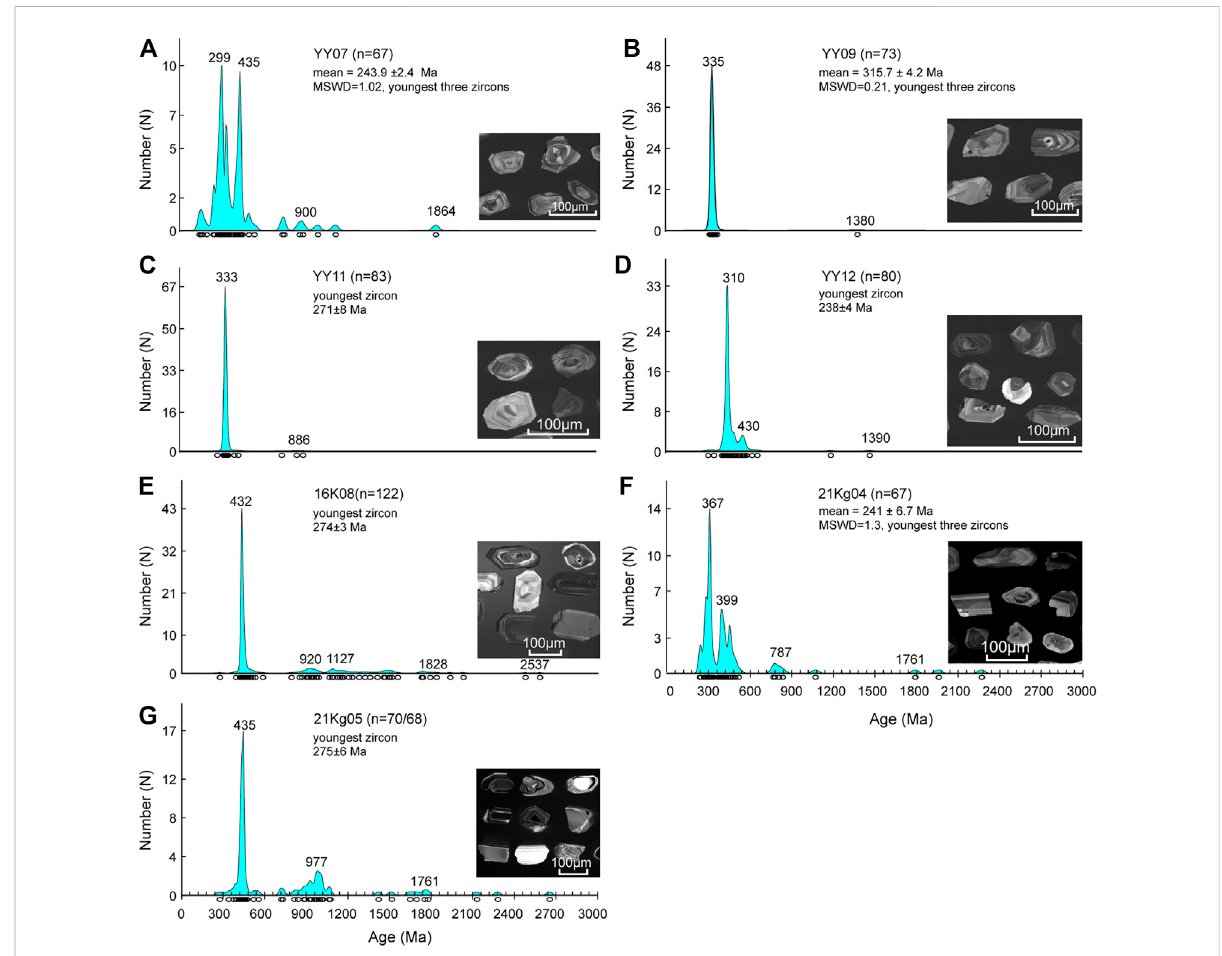
FIGURE 6 Histograms for the detrital zircons of the sandstones in the HL area (see Figure 2 for sample locations and supporting information and Supplementary Table S3 for data sources). (A) Sample YY07 of the north HL area shows multiple peaks detrital zircon age pattern. (B), (C) , and (D) SamplesYY09,YY11andYY12ofthenorthHLareashowsinglepeaksdetritalzirconagepatterns. (E),(F) ,and (G) Samples16K08,21Kg04and21Kg05 of the south HL area show multiple peaks detrital zircon age patterns. Ages of 206Pb/238U and 1 σ , with concordance % > 90% or < 110%, were used for density plots using DensityPlotter software Version 8.5 (Vermeesch,